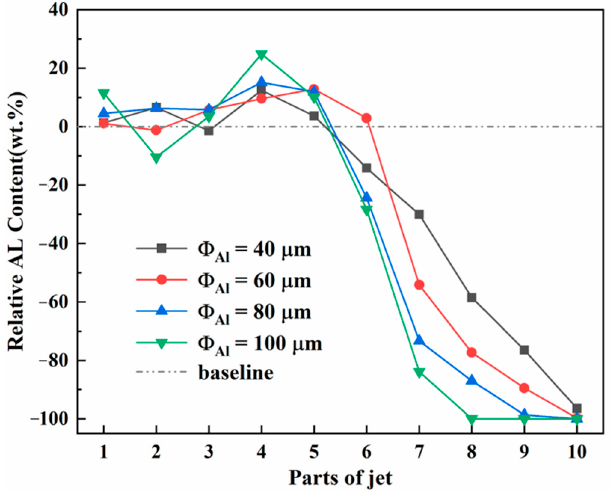
Figure 13. Relative Al content in each part of jet at 2 CD standoff. Note: The parts are defined using